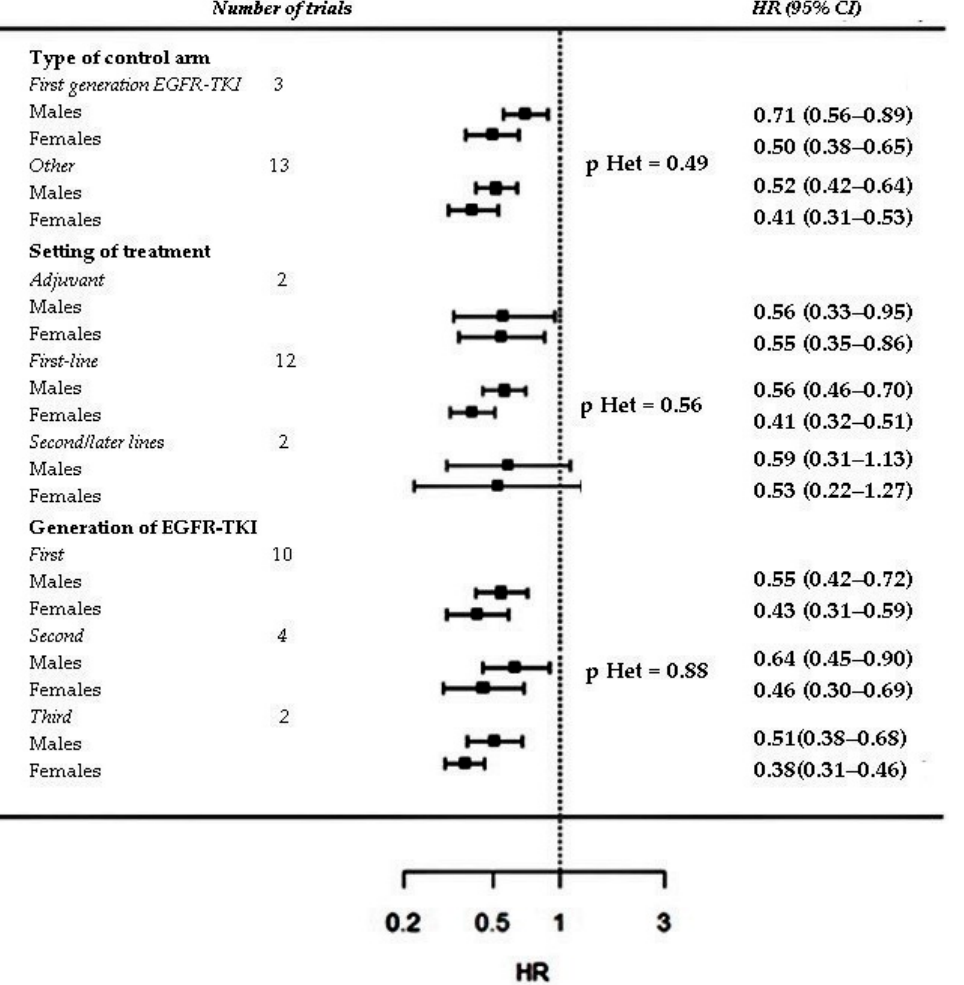
Figure 6. Subgroup analysis of PFS interaction with sex. Trials are grouped according to type of control arm (first-generation EGFR-TKI vs. other), setting / line of treatment (adjuvant vs. first line vs. second / later lines) and generation of the EGFR-TKI tested in the experimental arm (first vs. second vs. third). P value for heterogeneity (p Het) among pooled ratios of the PFS-HRs in males vs. females estimated in trial subgroups is provided.